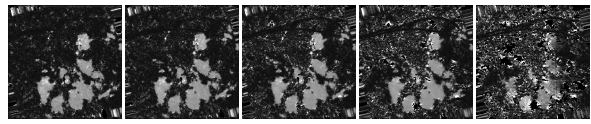
Figure 10. Resulting DEMs using weights of 0, 0.25, 0.5, 0.75 and 1 (l.t.r.) of the MI cost function (Census is one minus the weight of MI) for bands (2,4) and scale